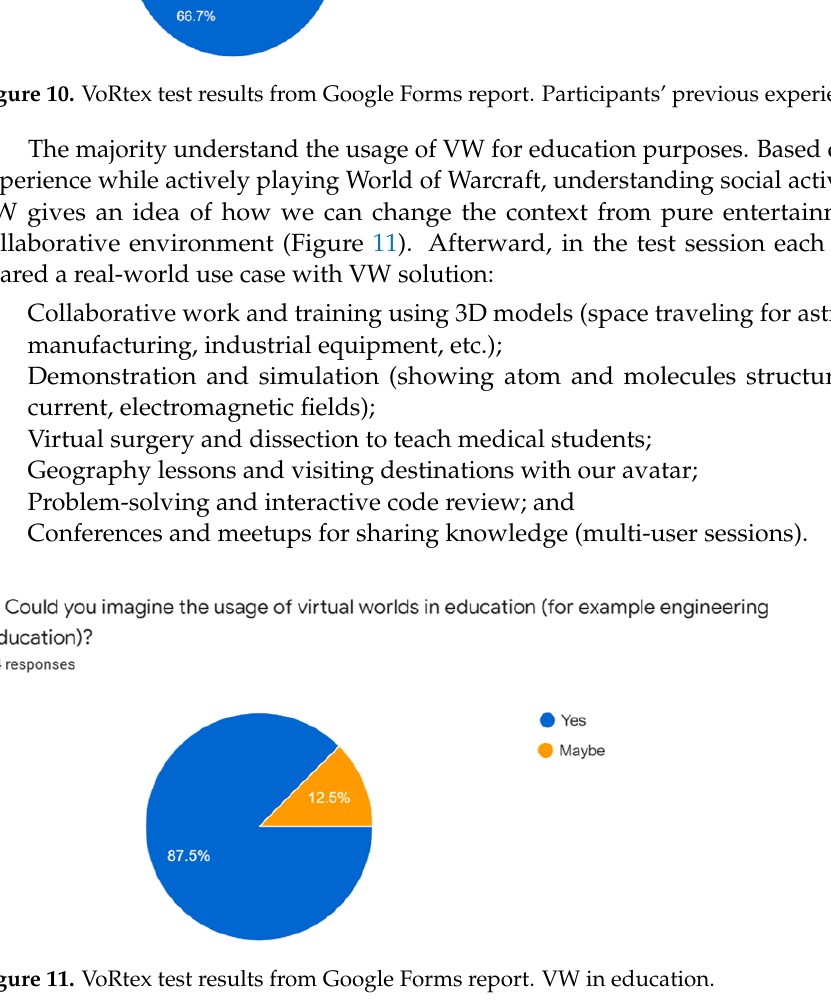
Figure 10. VoRtex test results from Google Forms report. Participants’ previous experience.